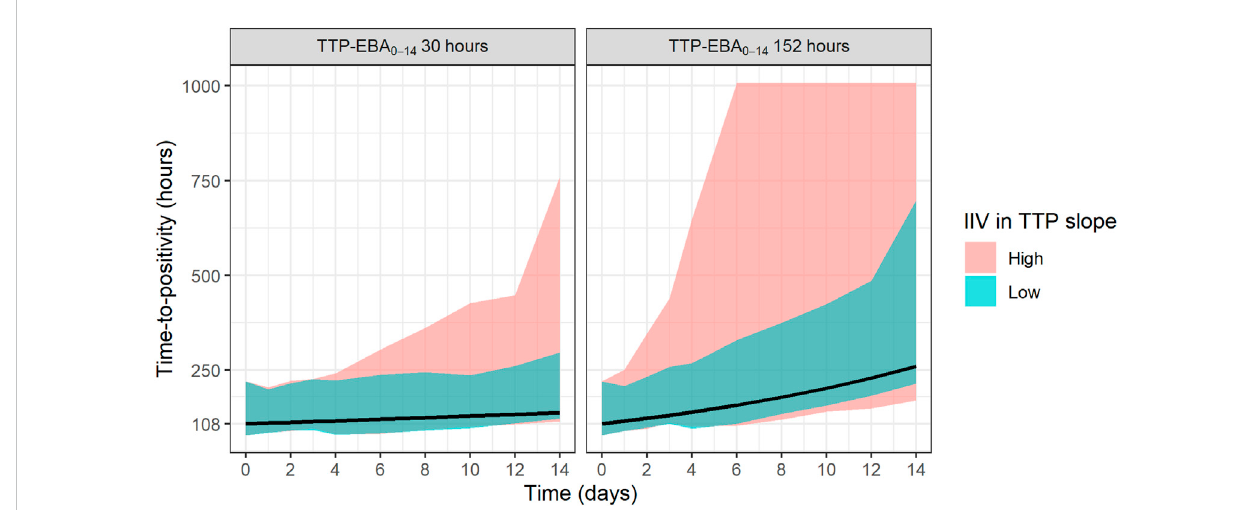
FIGURE 2 Visualizationoftypicalpro fi lesandvariabilityintime-to-positivity(TTP)overtimeforhigh[104%coef fi cientofvariation(CV)]andlow(22%CV)inter- individual variability (IIV) in EBA. TTP-EBA 0-14 is early bactericidal activity based on the difference in TTP between 0 and 14 days. Black lines represent the typical individual and shaded areas show the variability in predicted TTP derived from 30 randomly sampled individuals (95% prediction interval). The median baseline TTP was 1,008